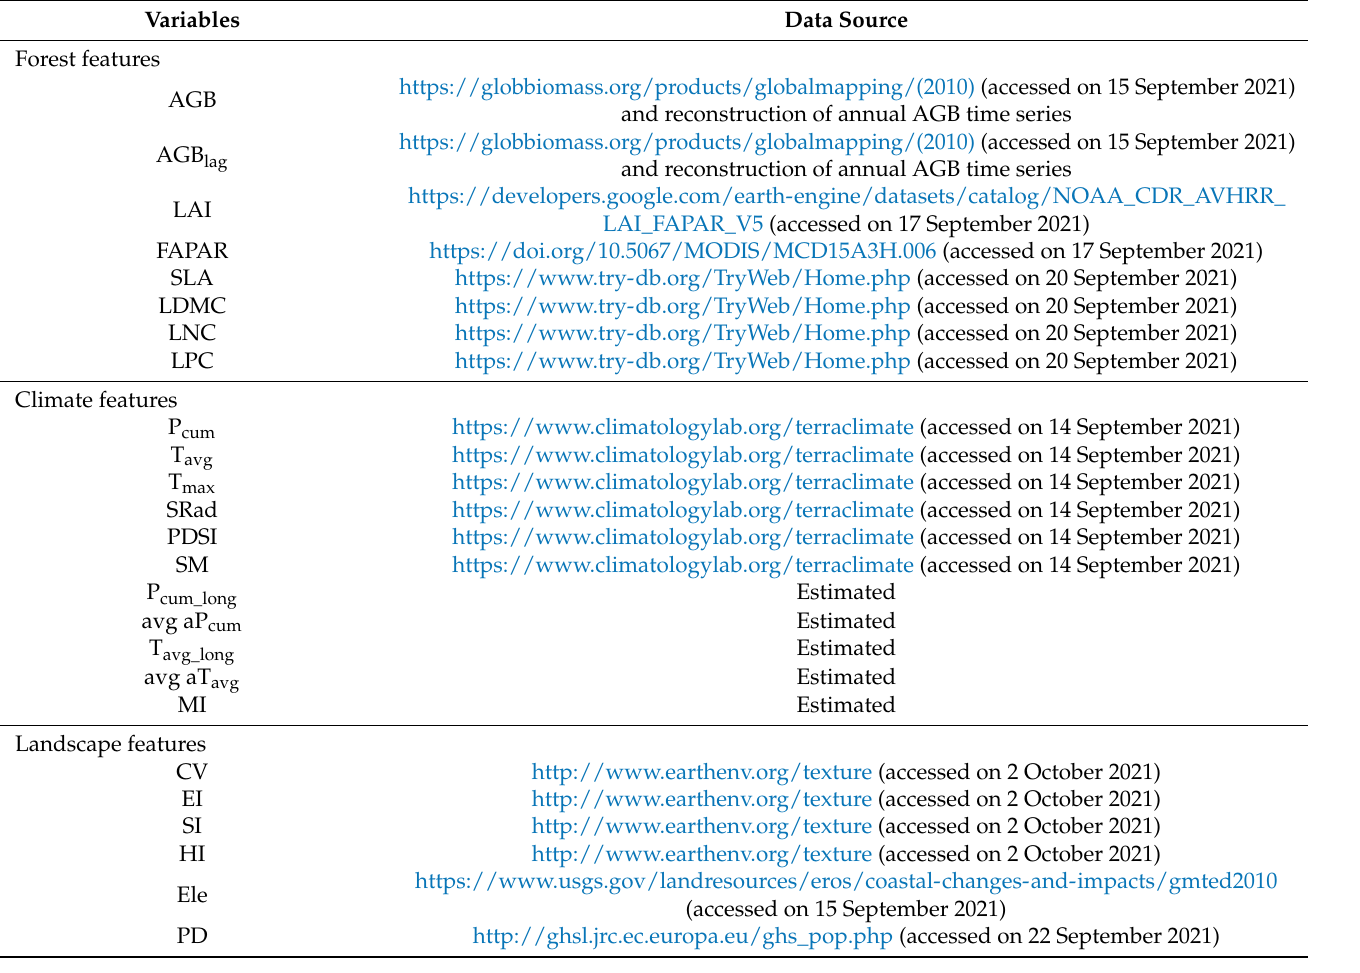
Table A1. Data sources of the explanatory variables used in vulnerability